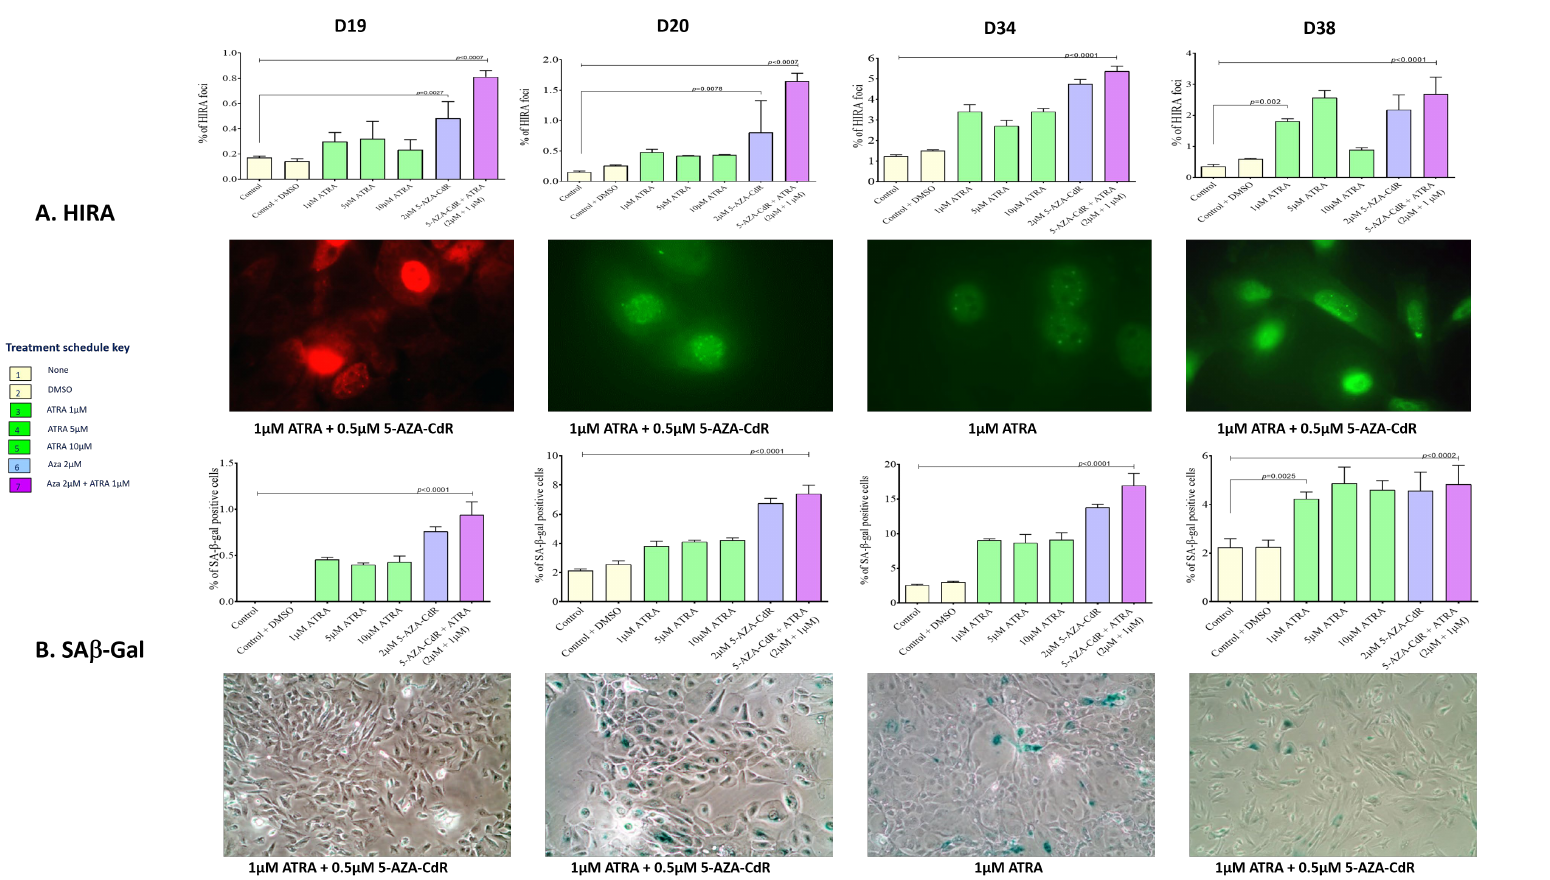
Figure 4. Senescence in ATRA and/or 5-AZA-CdR treated iPMOLs was assessed by assessment of SAH foci and SA- β -gal activity assay. ( A ) Assessment of senescence-associated heterochromatic foci (SAHF) was undertaken using immunofluorescent assessment of HIRA. The mean frequency of HIRA foci showed a higher accumulation in iPMOL cells (D19, D20, D34, and D38) when treated with the combination of 5-AZA-CdR with ATRA or alone compared to the control ( p < 0.0007). ( B ) Mean percentage values of SA- β -gal positive cells were significantly higher in D20 and D34 cell lines ( p < 0.0001) than in D19 and D38 when compared to the untreated controls. D34 and D38 cells showed significant increase in the HIRA foci and SA- β -gal activity even when treated alone with the various concentrations of ATRA and/or 5-AZA-CdR. Statistical significance was determined using one-way ANOVA with post hoc Dunnett’s test ( p <